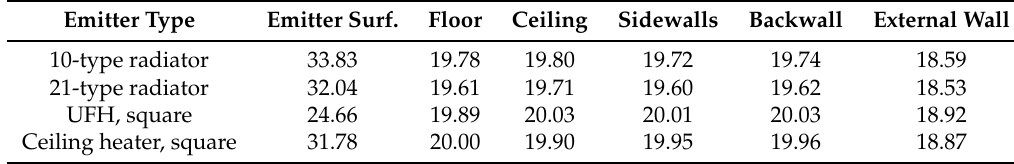
Table 2. Emitter and room surface temperatures [ ◦ C] for minimal sized